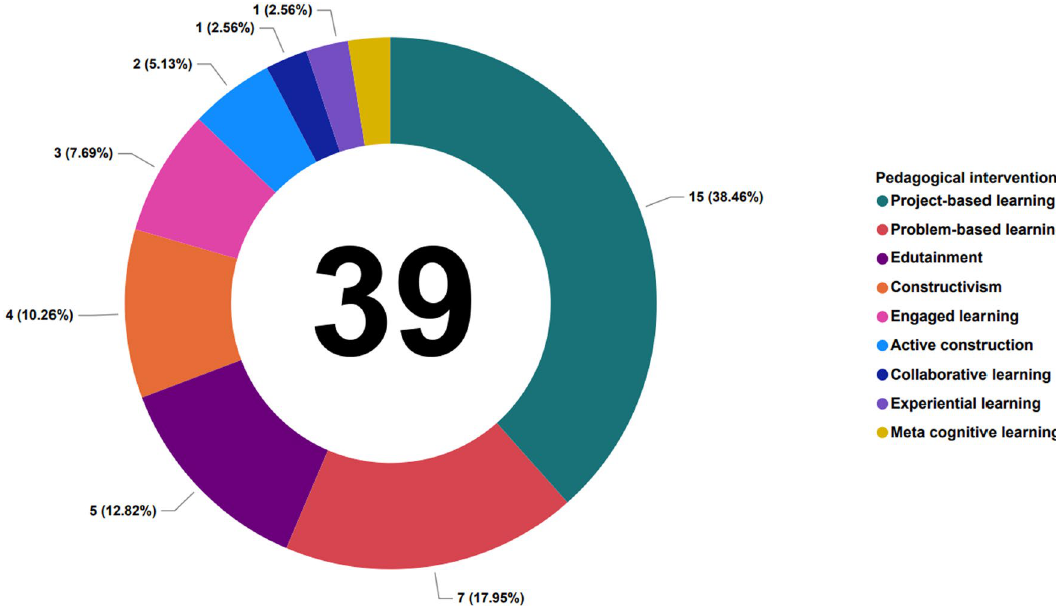
Fig. 12 The pedagogical interventions in R‑STEM